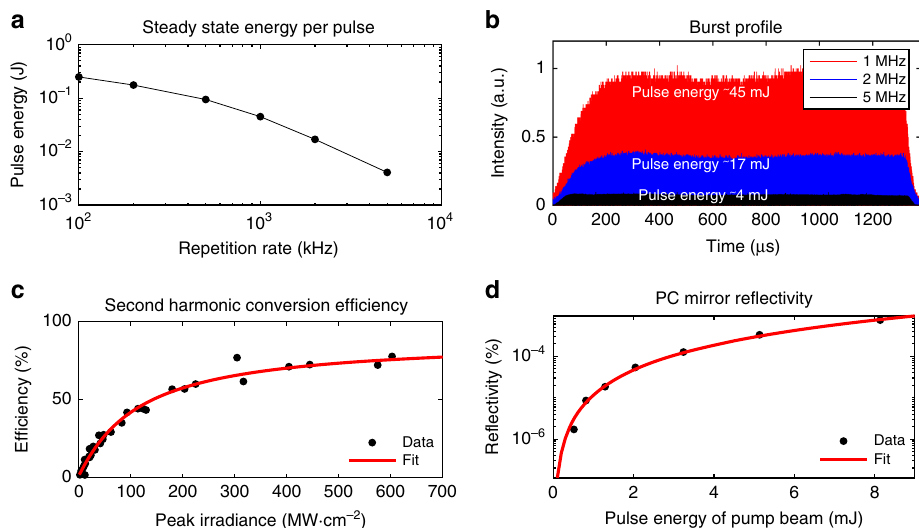
Fig. 3 Ultra-high-speed PCDIH system characterization. a Average pulse energy at steady state and b burst pro fi les at 532 nm are shown. c The second harmonic conversion ef fi ciency from 1064 to 532 nm with logistic fi t and d the phase conjugate mirror re fl ectivity as a function of pump energy with a tangent-squared fi t to the analytical expression in Eq. (7) are also illustrated. Source data are provided in the Source Data fi